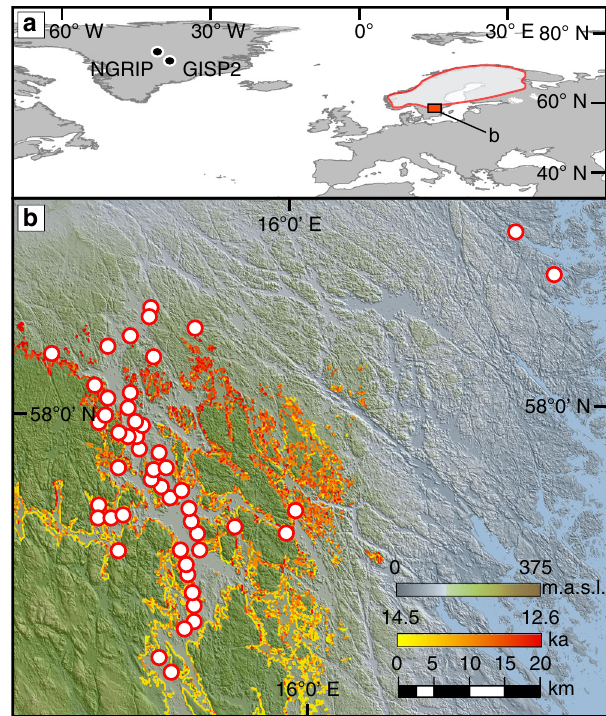
Fig. 1 Location of the Swedish varve and Greenland ice-core records. a Study area with Younger Dryas ice-marginal line (red contour) 13,69 and the location of GISP2 and NGRIP ice cores in Greenland. b LiDAR-based topography showing the location of the sites used to construct the clay- varve chronology presented in this study (red circles). The highest shoreline of the Baltic Ice Lake is also displayed. Coastline data from the Geological Survey of Sweden colored according to present-day elevation (highest lake position was time-transgressive: yellow to